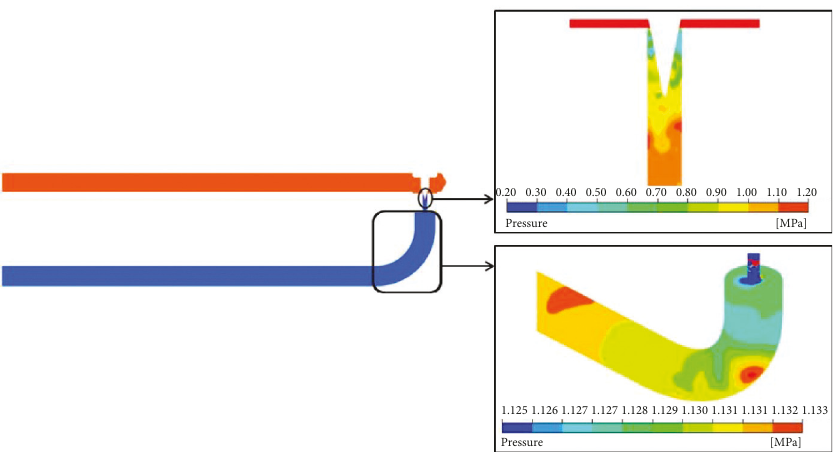
Figure 6: Contour of total pressure.